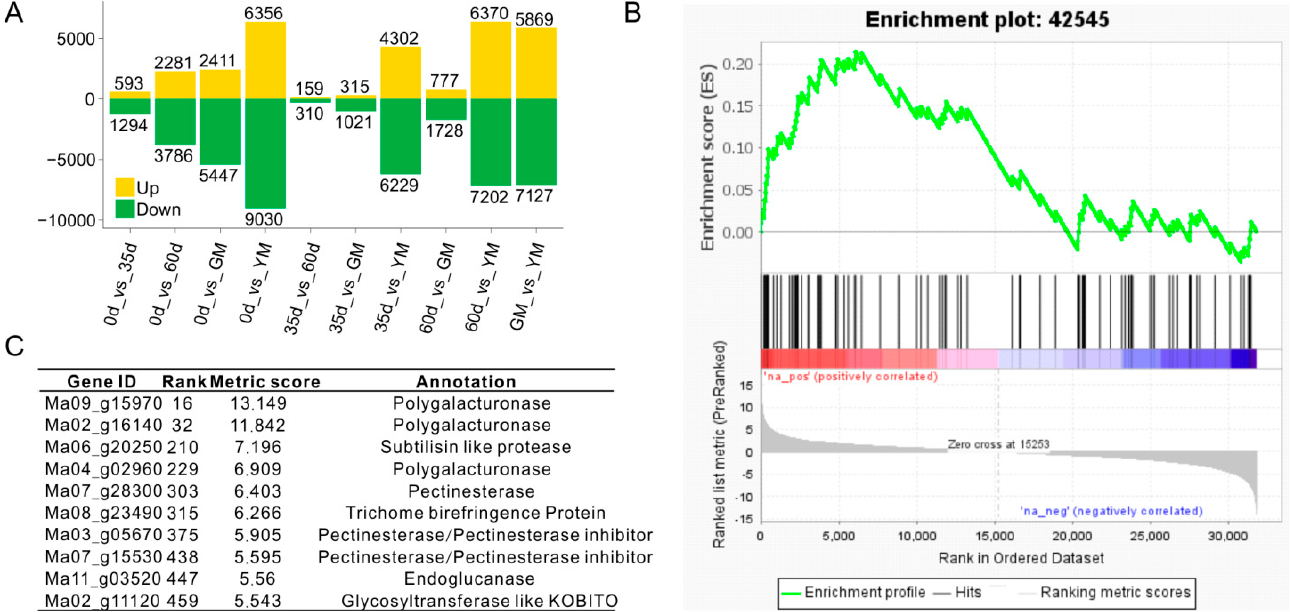
Figure 2. Functional analyses of differentially expressed genes in banana ( Musa spp. AAA) peel during fruit development and ripening. ( A ) Numbers of genes upregulated and downregulated in comparison between every two stages; ( B ) Gene Set Enrichment Analysis result of cell wall modifi- cation; ( C ) Top 10 genes in Core Enrichment Gene Set, which includes 3874 members in banana genome. 0 d: fruits just emerging from the bunch; 35 d: 35 day-old fruits; 60 d: 60 day-old fruits; GM: green matured fruits (at harvest, 85 day-old fruits); YM: yellow matured fruits (6 d after eth- ylene